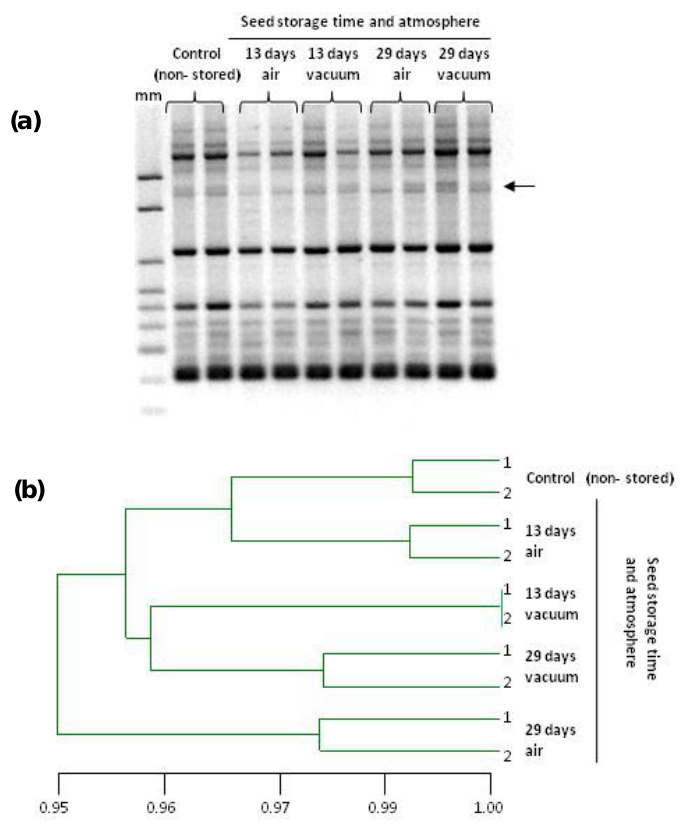
Figure 2. DNA stability in S. cereale seedlings obtained from stored seeds: ( a ) Representative RAPD profile of amplification with primer OPO-5 obtained from DNA of seedlings produced from stored and control (non-stored) seeds; ( b ) Dendrogram generated by the UPGMA method using Jaccard’s similarity coefficient, based on RAPD markers. Seeds were stored at 35 °C, 15% wc and two different storage atmospheres: air or vacuum. mm = 100 bp ladder marker. DNA was isolated from two replicates of 10 seedlings per storage condition.